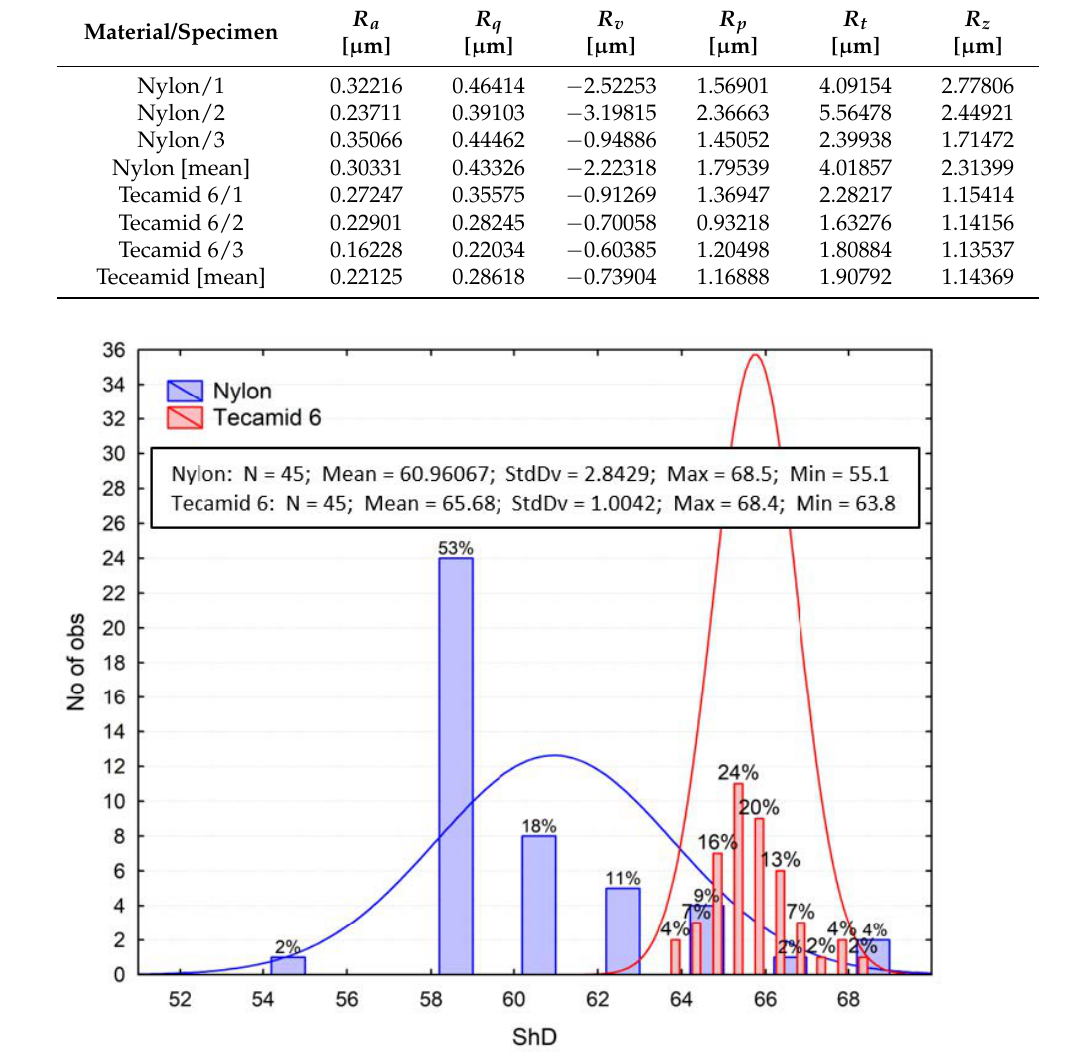
Figure 6. Distribution series of Shore hardness test results.